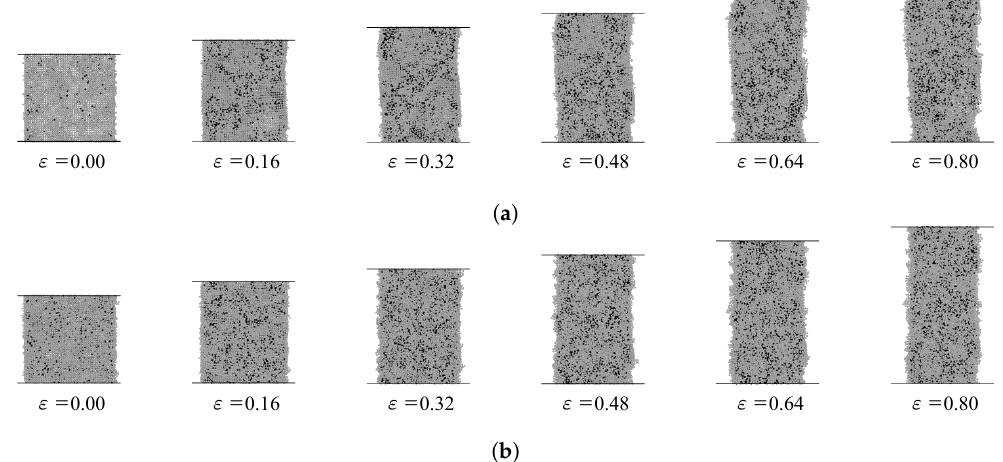
Figure 6. Distribution of the HCP atoms (black dots) in the Cu-Zn alloy models with the zinc content of ( a ) 2.5% and ( b )